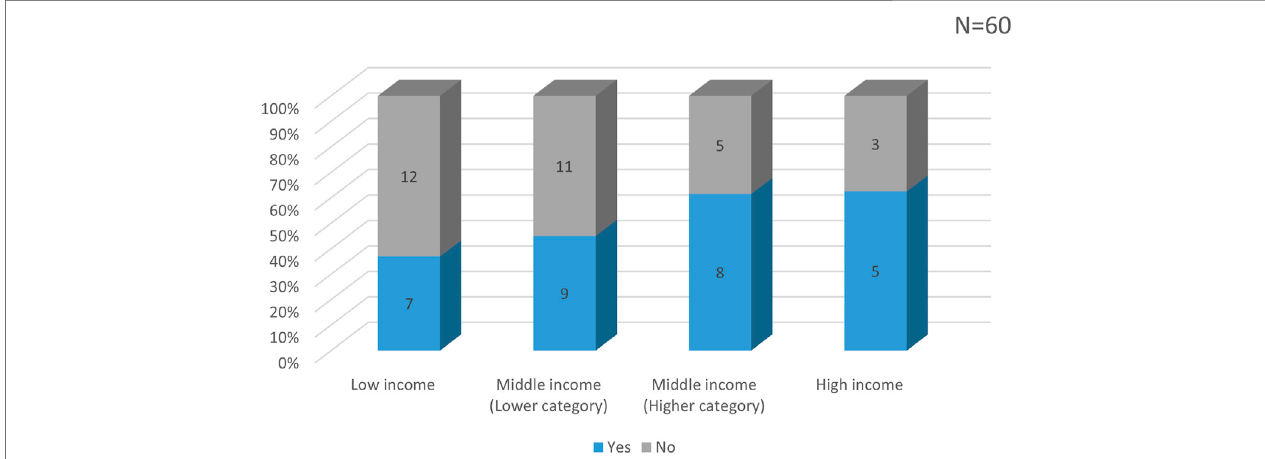
FIGURE 1 | Number of countries with teacher training institutions for the deaf (adapted from WHO 2014,